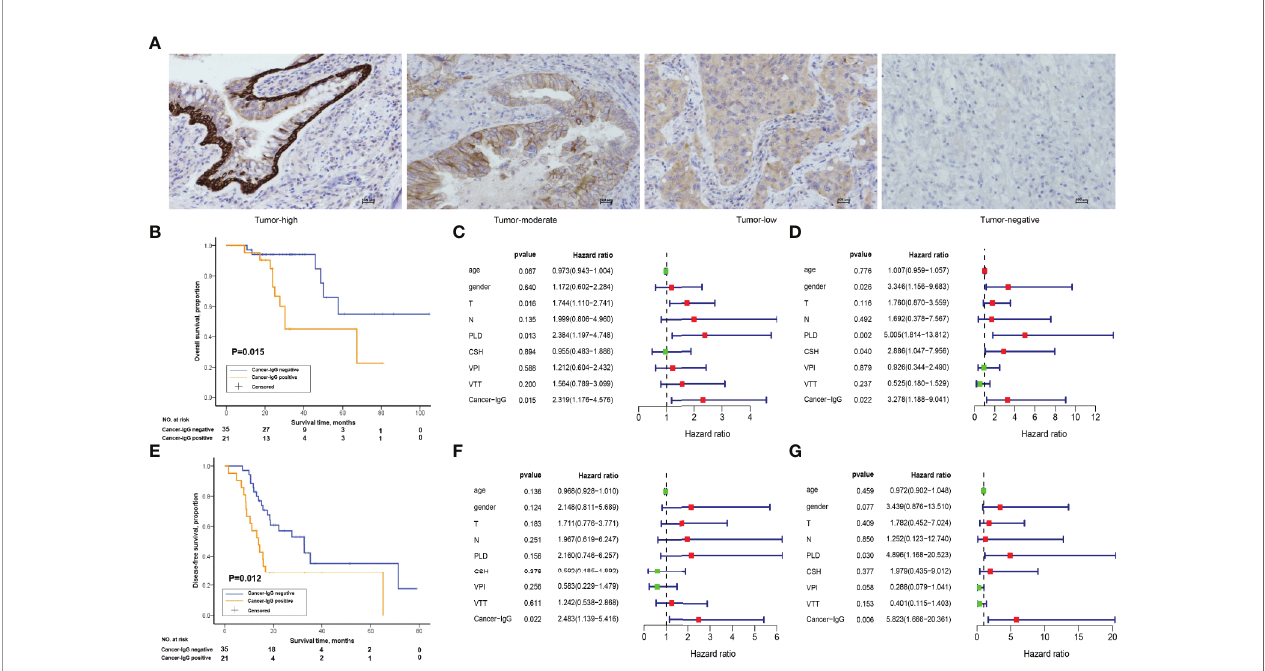
FIGURE 1 | The relationship between the expression of cancer-derived immunoglobulin G (cancer-IgG) and survival outcome in 56 patients with stage III lung adenocarcinoma (LUAD). (A) Different expression levels of cancer-IgG in LUAD tissue sections. Scale bar, 100 m m. (B) Kaplan-Meier analysis of the overall survival (OS) between positive and negative cancer-IgG expression groups. (C, D) Univariate and multivariate analyses using a Cox proportional hazards model for the OS of patients with LUAD. (E) Kaplan-Meier analysis of the disease-free survival (DFS) between positive and negative cancer-IgG expression groups. (F, G) Univariate and multivariate analyses using a Cox proportional hazards model for the DFS of patients with LUAD. Age; gender: 0 (female), 1 (male); T: 1, 2, 3, 4; N:1, 2, 3; primary lesion diameter (PLD): 0 (< 4 cm), 1 ( ≥ 4 cm or double lesions); cigarette smoking history (CSH): 0 (never), 1 (former or current); visceral pleura invasion (VPI): 0 (no), 1 (yes); vascular tumor thrombus (VTT): 0 (no), 1 (yes); cancer-IgG: 0 (negative expression), 1 (positive